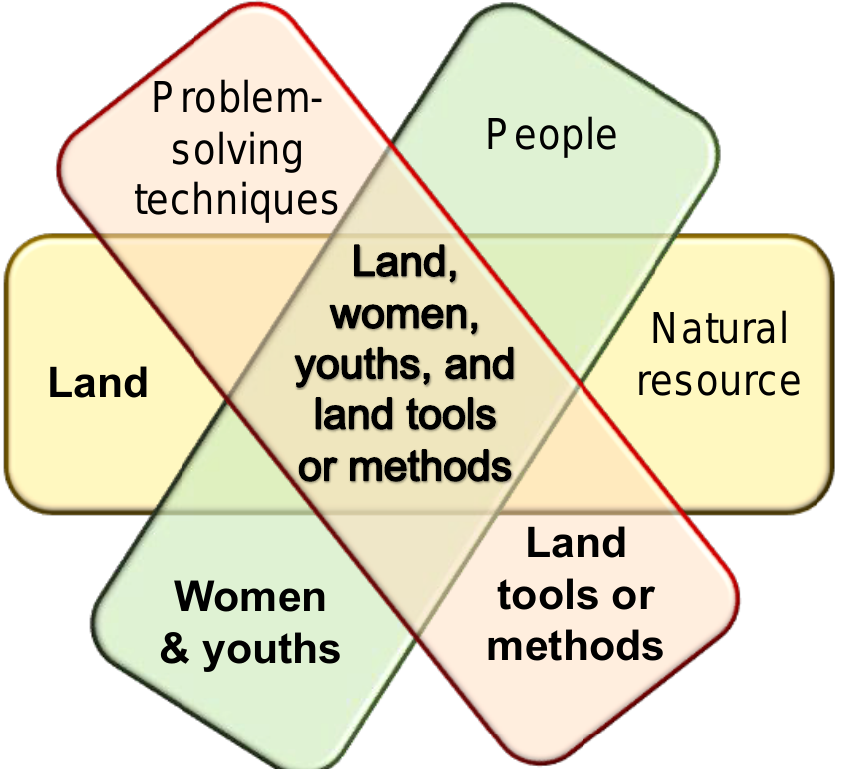
Figure 1. The relationship between land, women, youths, and land tools or methods (author’s illustration).